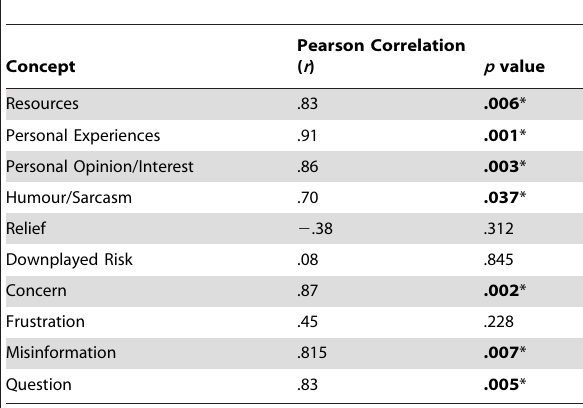
Table 6. Correlations between Manual and Automated